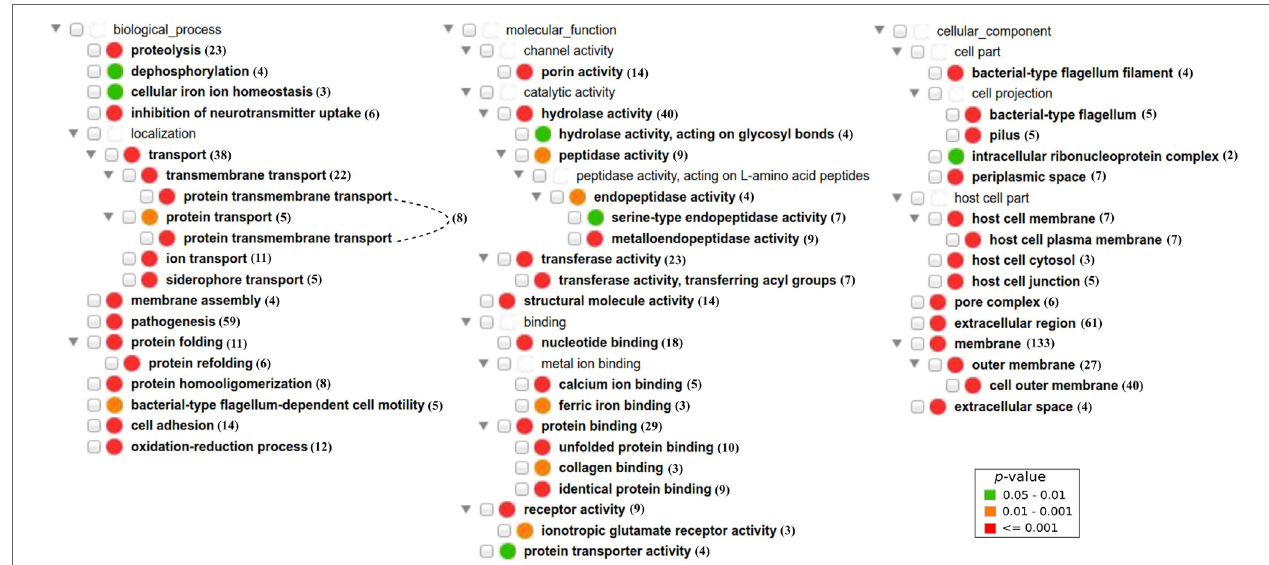
FigUre 5 | Over-representation of GO BP, MF, and CC term profiles among reported protective antigens (PAgs) and visualized using the GOfox tool. The number next to each GO term indicates the number of PAg with the corresponding GO functional annotation. Similar to COG clustering, GO terms that are related to pathogen motility, secretion, signal transduction, and transportation are also significantly enriched in PAgs as compared with non-protective proteins. The GO CC terms also supported the high preference of extracellular, surface-exposed (cell wall in G + and outer membrane in G − ), and periplasmic (G − ) PAgs. The significant over-representation of PAgs’ GO terms compared with non-protective proteins is color-coded following the legend in the lower right